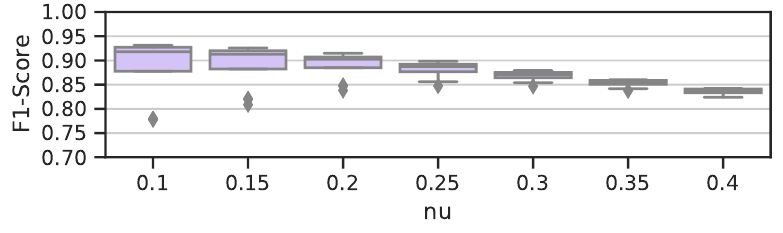
Figure 5. F1-Score from OCSVM using seven ν values.